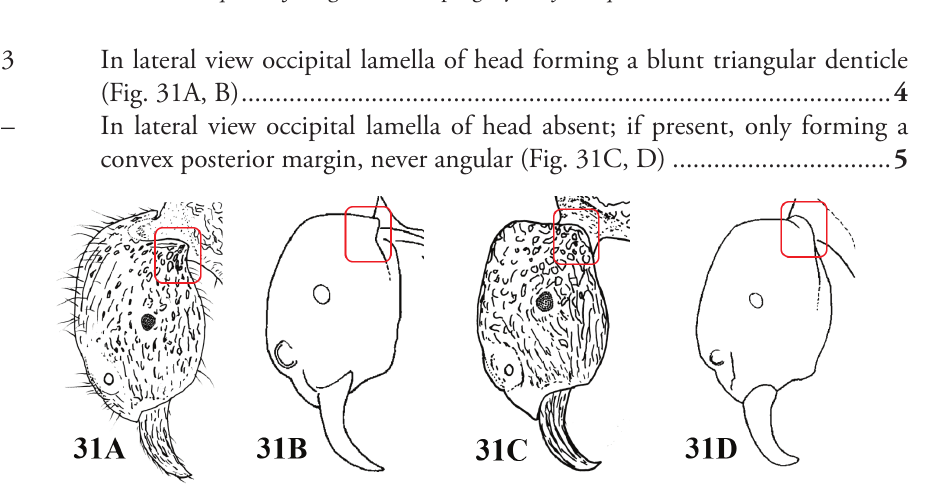
Figure 31. A G. dentihumera worker B G. panda worker (Cited from Lattke, 2004) C G. taivanensis worker D G. sichuanensis worker (Cited from Lattke, 2004). 4 In lateral view propodeum with short triangular denticle; subpetiolar process triangular (Fig. 32A) ............ G. dentihumera Chen, Lattke & Zhou, sp. n. – In lateral view propodeum without denticle, posterodorsal corner rounded; subpetiolar process polygonal, anteroventral corner bluntly angular, ventral